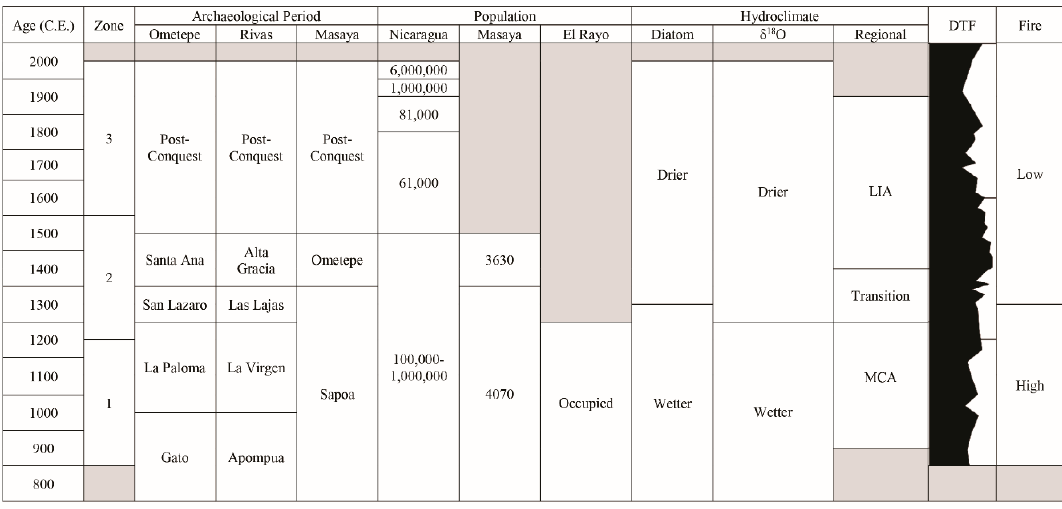
Table 2. Chronology of palynological zones, archaeological periods [52,53,117] local populations [45–48,51,116,117] and climatic shifts [16].